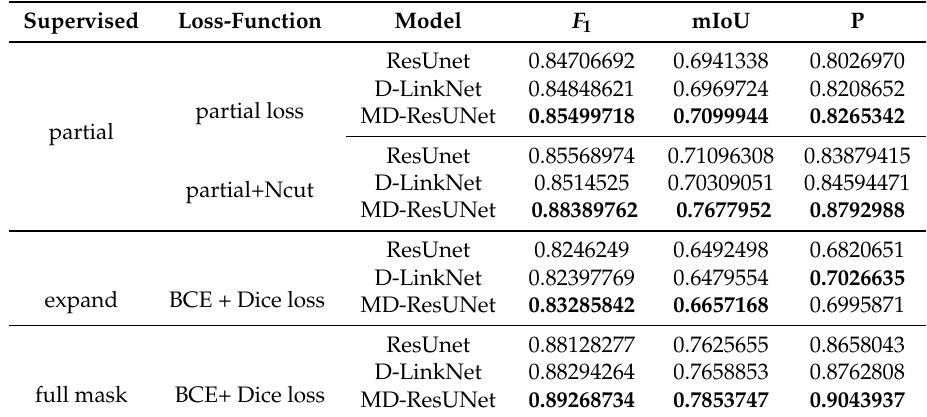
Table 6. Road extraction performance using different supervised data and different loss function and different deep learning method on dataset 2